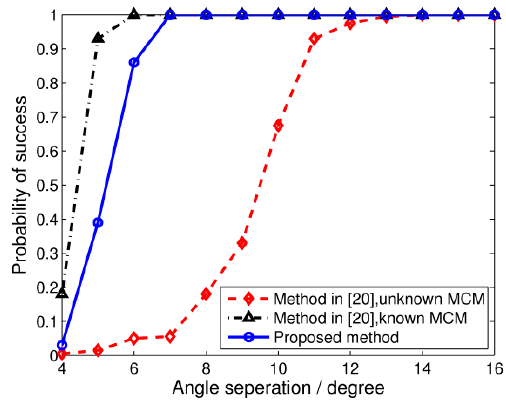
Figure 6. Success probability of DOA estimation versus the angle separation of incident signals. SNR = 0 dB, snapshots = 64.